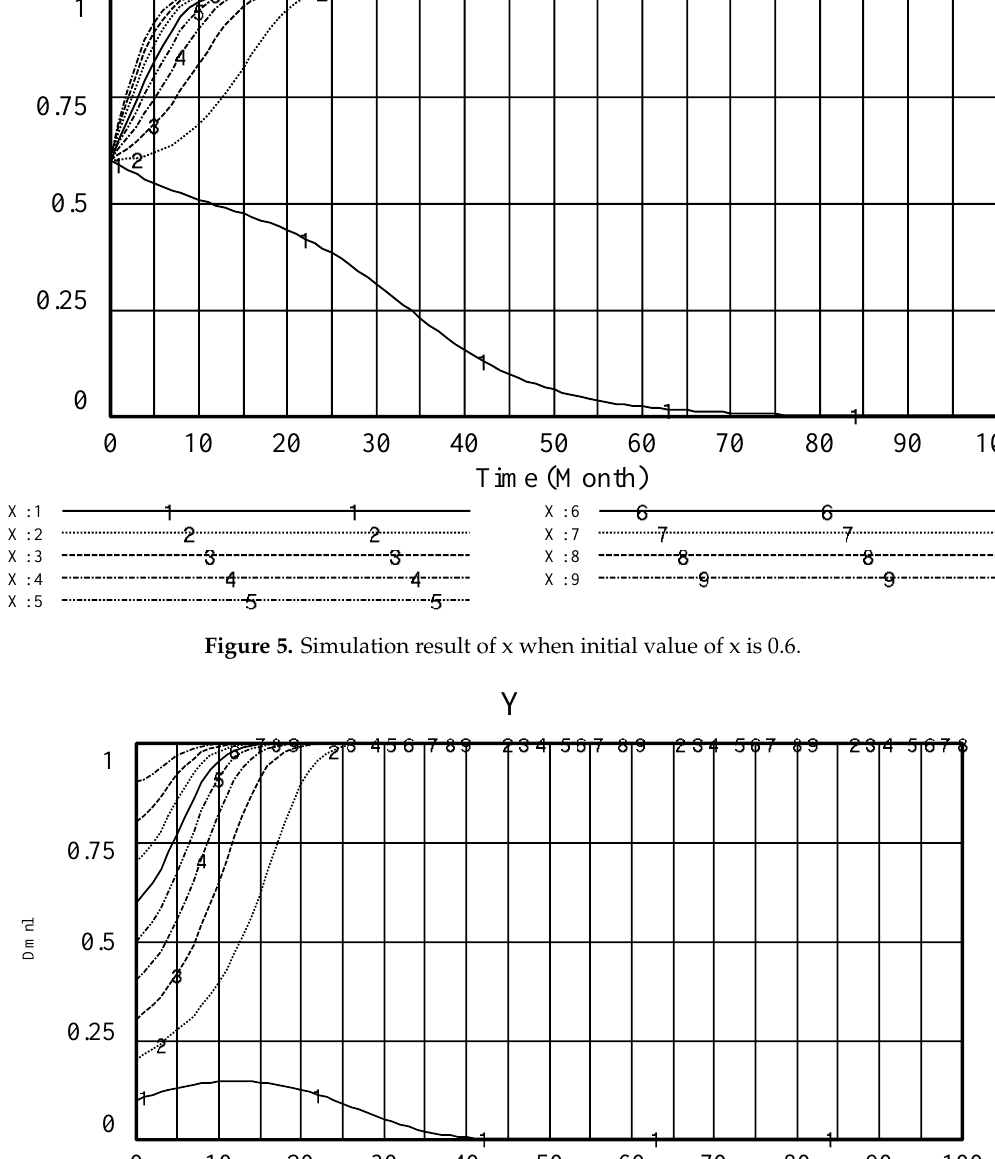
Figure 4. Simulation result of y when initial value of y is 0.3.